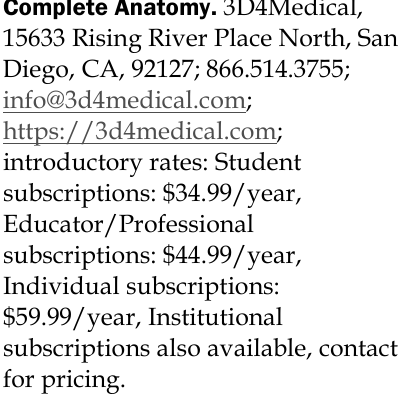
Figure 1 Visualization of Complete Anatomy augmented reality mode